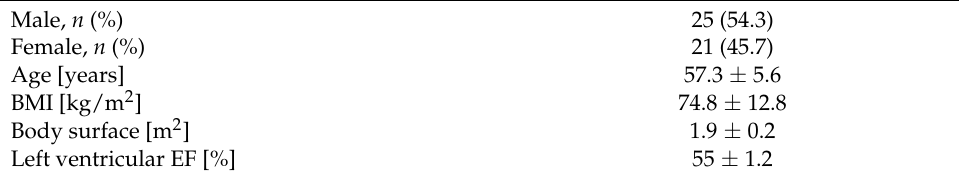
Table 3. Baseline demographics of the healthy individuals.